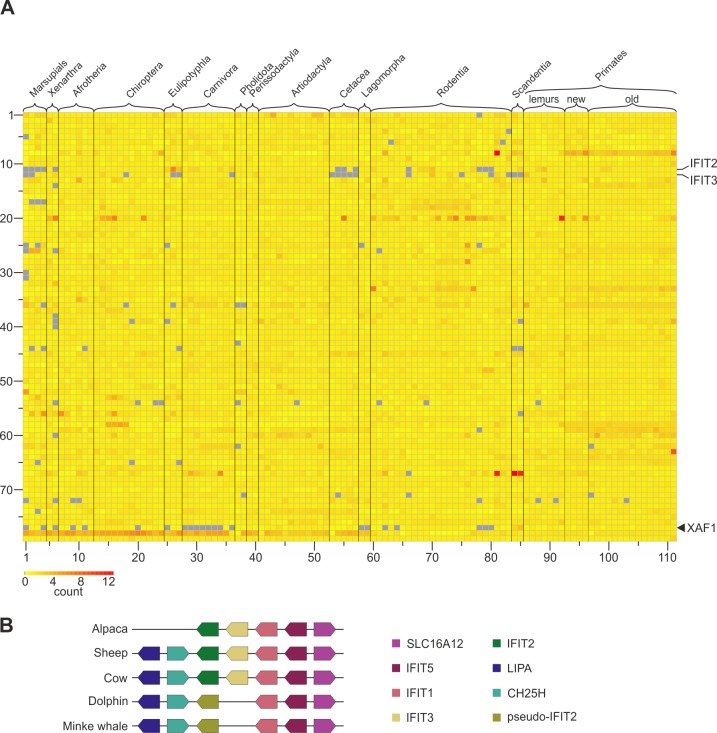
In silico screening of coremamm ISGs in mammalian genomes.(A) A heatmap displaying the results of a similarity search–based screen of 111 mammalian genomes for sequences disclosing homology to mammalian core ISGs. Each column represents a distinct mammalian species, while each row represents a coremamm ISG. Numbers on the left of each row identify each ISG as listed in S3 Table. Column numbers refer to species (S4 Table). Colours are proportional to the number of matches found in each genome, normalised by the median hit count for that gene across the Mammalia. Because the method is based upon sequence-similarity screening, high count levels for a particular gene do not necessarily reflect gene expansion. Note that the grey boxes indicate that no matches were identified, either due to a bona fide deletion or as a result of relatively poor quality of the genomes. Note that only 79 coremamm ISGs are included in the analysis. Some of the coremamm ISGs were excluded from this analysis because of their high levels of similarity between each other posing a risk for spurious results. (B) A cartoon of syntenic loci showing the absence of IFIT3 and pseudogenisation of IFIT2 in cetaceans. ISGs, interferon-stimulated genes.